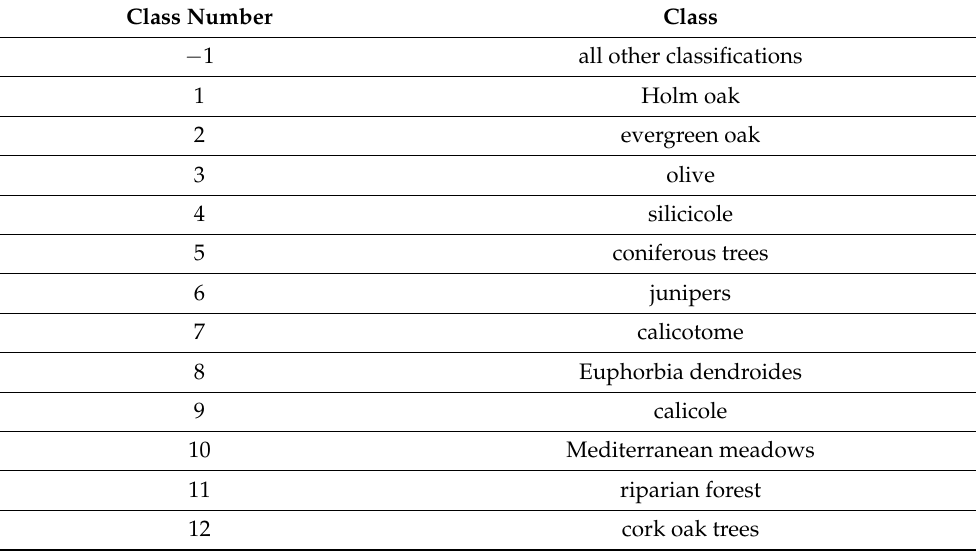
Table 2. Various Classes of Land Use, Land Cover